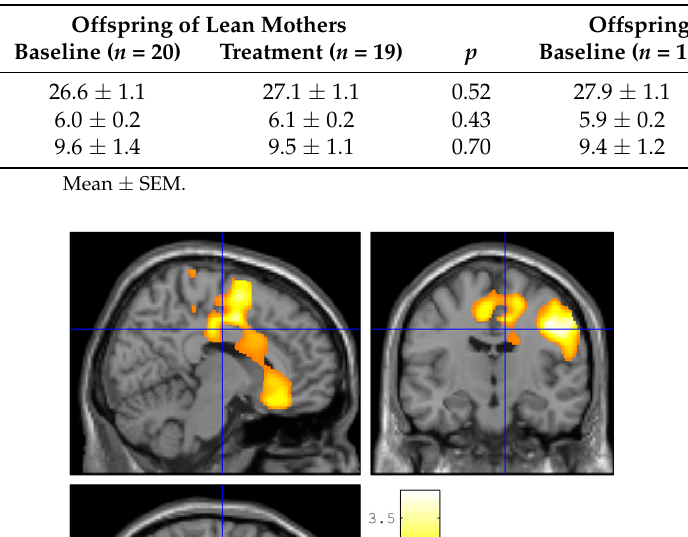
Table 2. Effect of exercise on general characteristics in frail groups sub-divided according to mater- nal BMI.